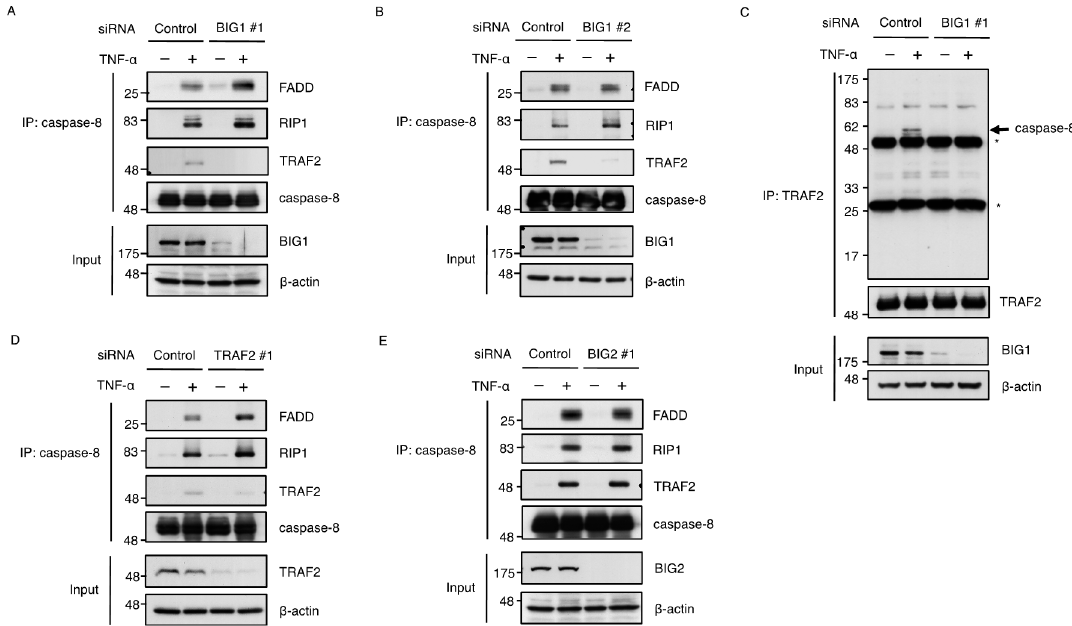
Figure 6. BIG1 is involved in the recruitment of TRAF2 to the death-inducing complex. ( A – E ) HT1080 cells were transfected with indicated siRNAs. After 72 h, the cells were treated with 50 ng/mL TNF- α for 4 h. The cell extracts were immunoprecipitated with caspase-8 or TRAF2 antibody followed by immunoblotting with the indicated antibodies. Asterisks (*) in ( C ) indicate the heavy and light chains of IgG.